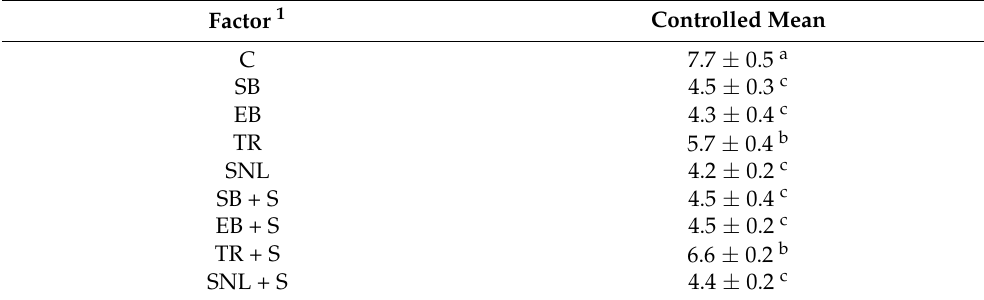
Table 3. Means and standard deviations for width-to-thickness ratios of each